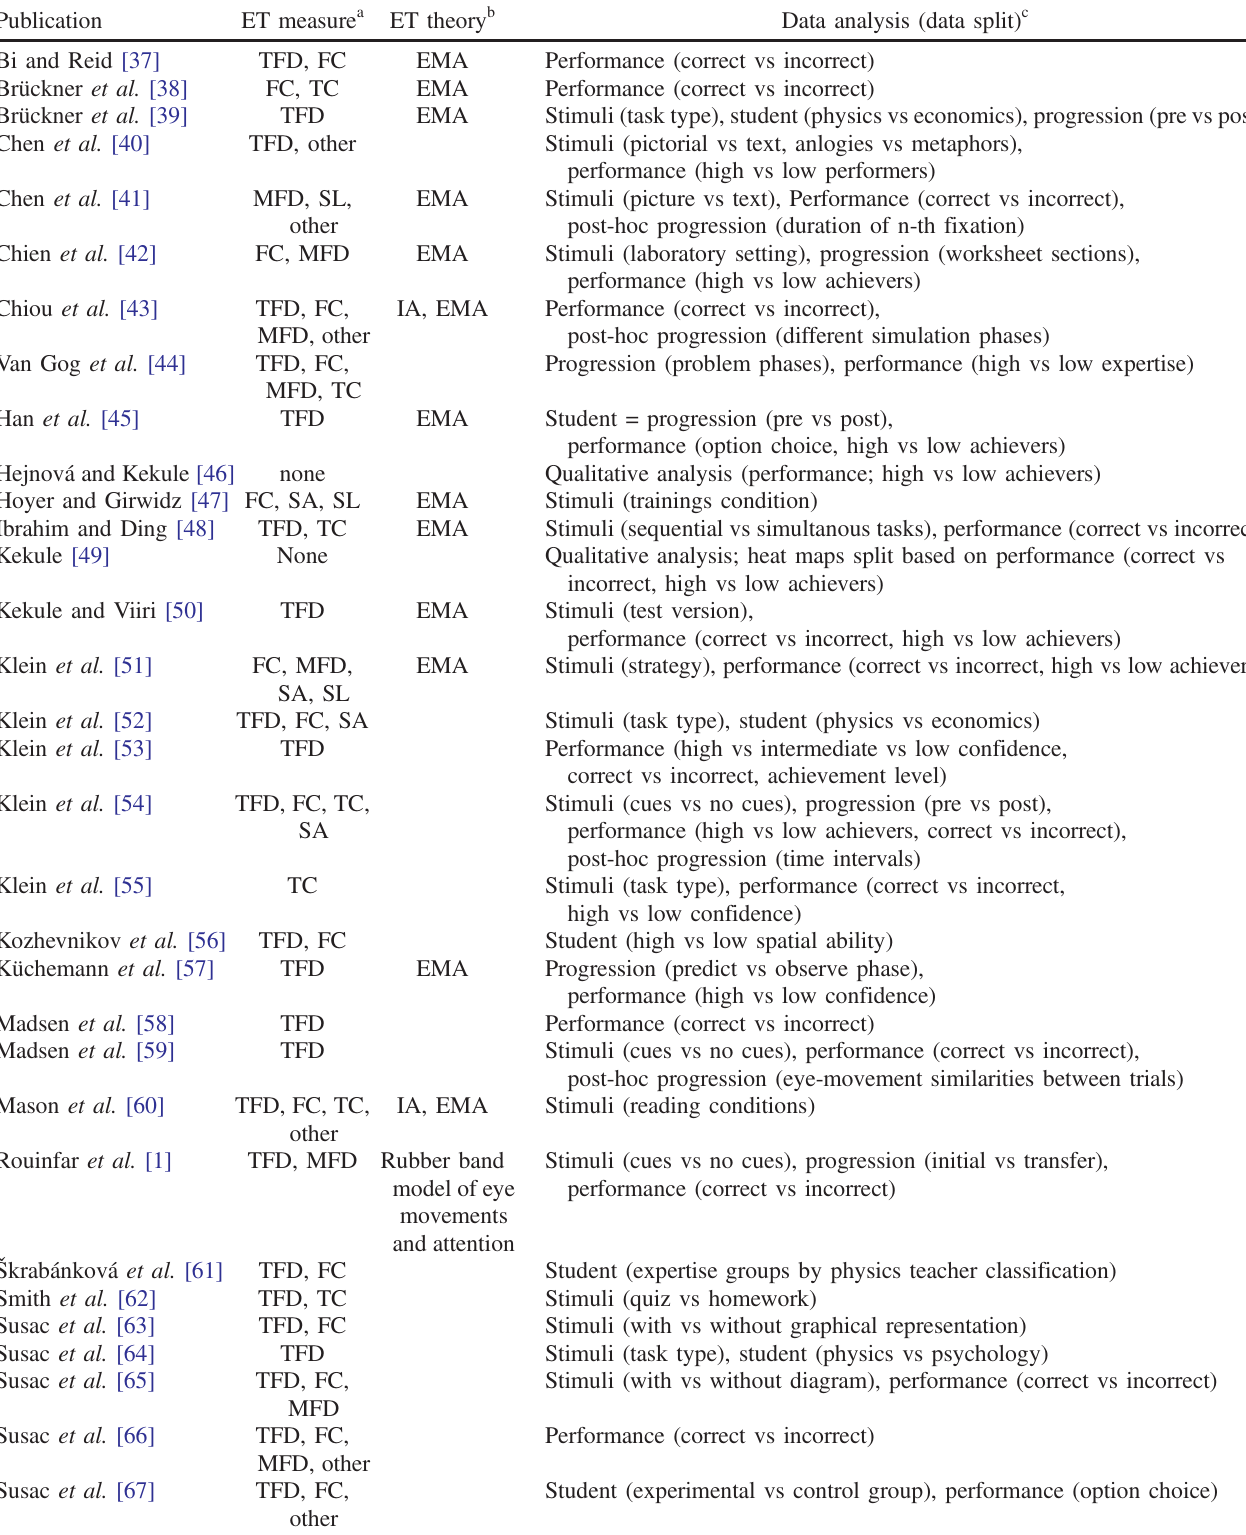
TABLE X. Eye-tracking measures and variables used in the studies: